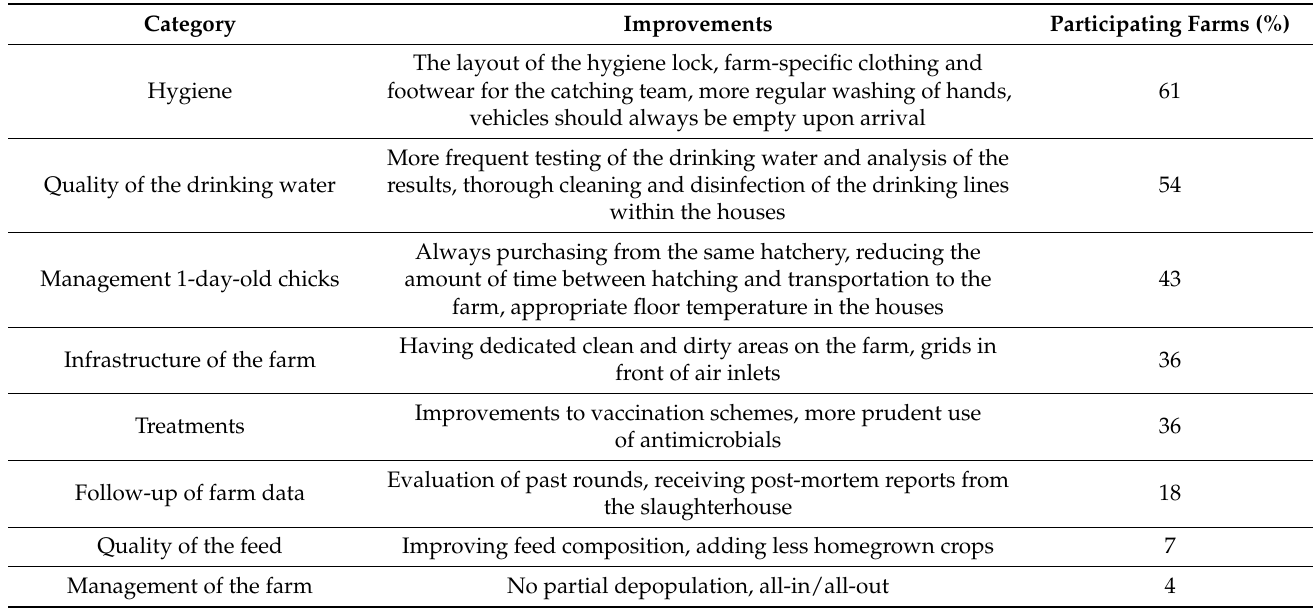
Table 2. The percentage of farms in Belgium and the Netherlands where the different improvement categories were